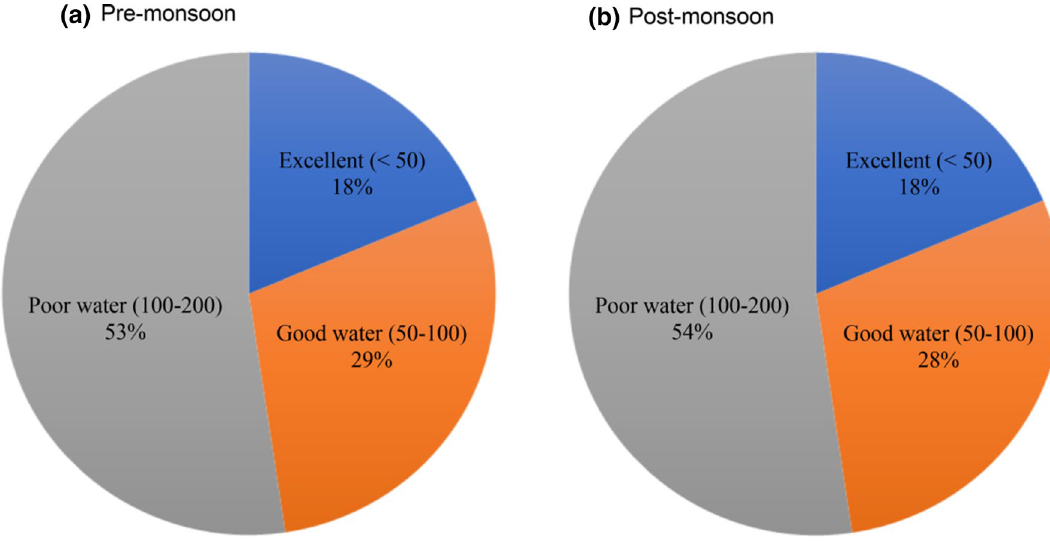
Fig. 13 Categorization of groundwater according to WQI; a PrM; b